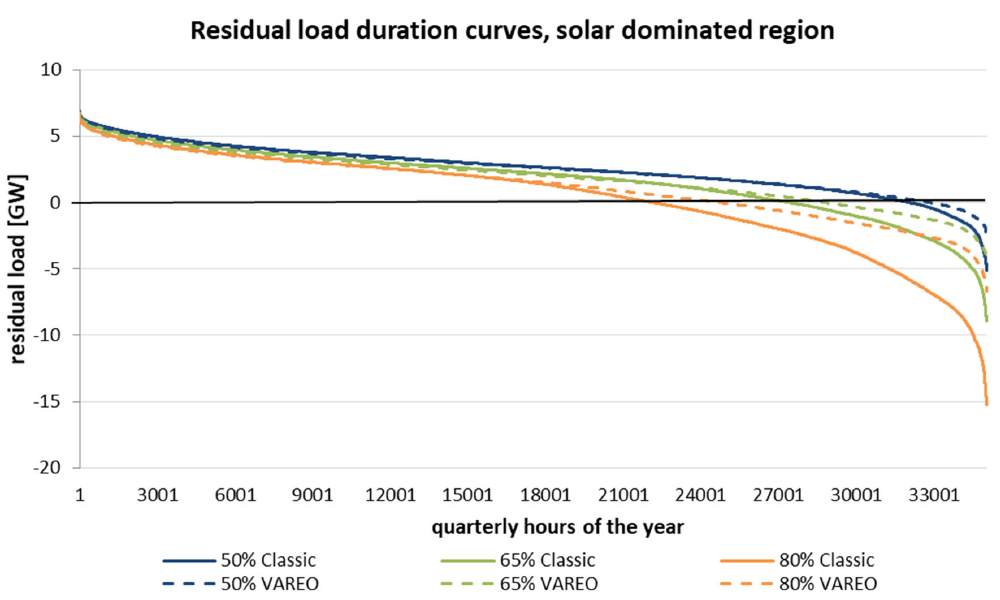
Figure 6. Residual load duration curves of the six different scenarios in the solar ‐ dominated region, showing how the residual loads throughout the sorted annual load values are composed in the three different time periods and either a classical or VAREO optimized mix (dashed lines) of wind and solar PV.